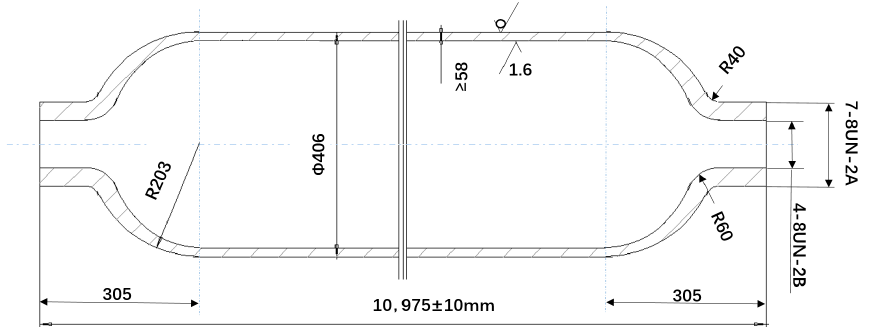
Figure 1. The dimensions of the high-pressure hydrogen storage cylinder.